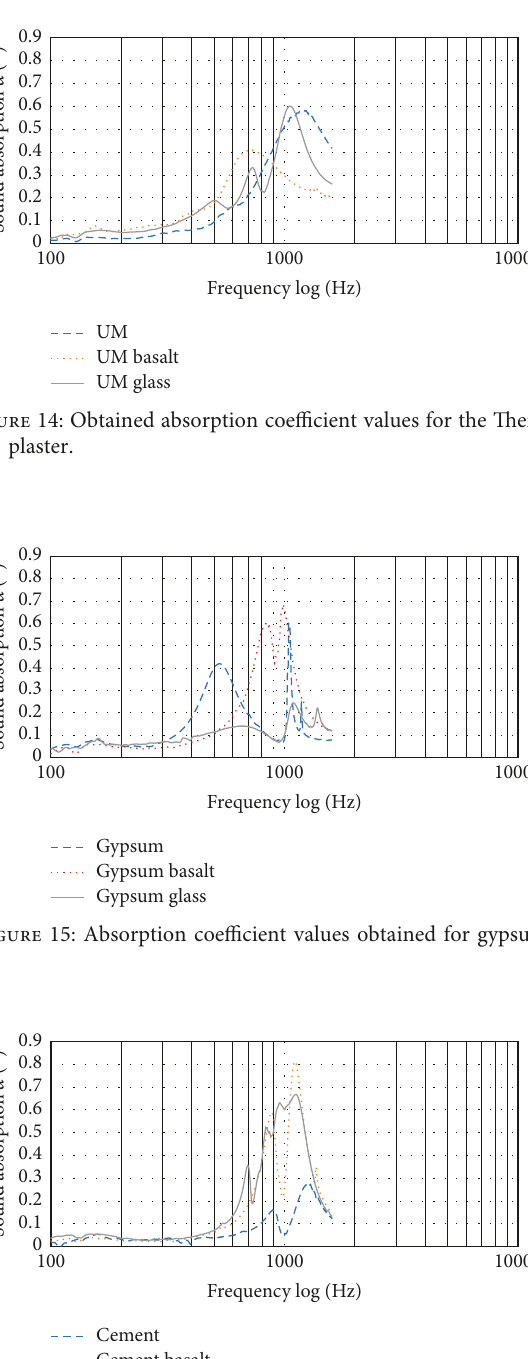
Figure 11: Comparison of the FEM model for gypsum with basalt fibre (upper) and gypsum with glass fibres (lower).